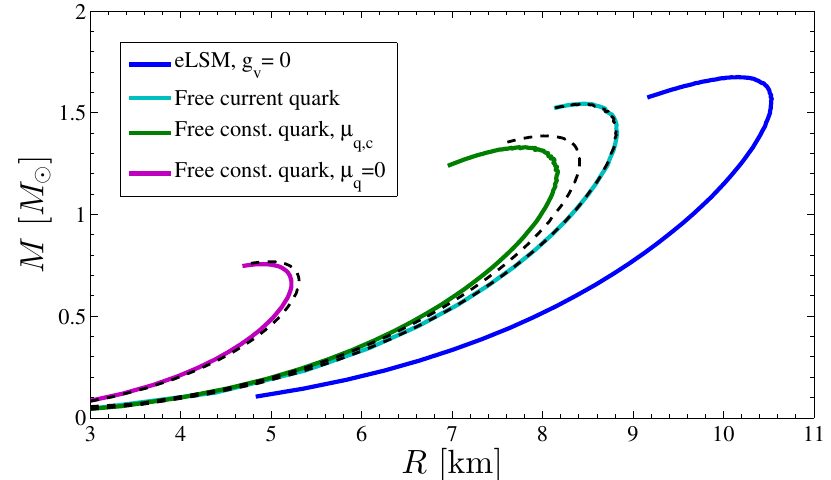
Figure 5. M ( R ) curves of the non-interacting quark model with three different quark mass setups (left curve: m u = m d = 322 MeV, m s = 458 MeV; middle curve: m u = m d = 75 MeV, m s = 365 MeV; and right curve: m u = m d = 0 MeV, m s = 90 MeV) compared to the M ( R ) curve of the eLSM model with g v = 0 in which the quark masses change (rightmost curve). The dashed curves are obtained without imposing the constraints of charge neutrality and β -equilibrium.